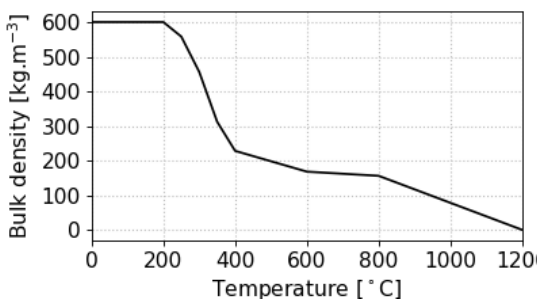
Figure 9. EC5 timber bulk density.